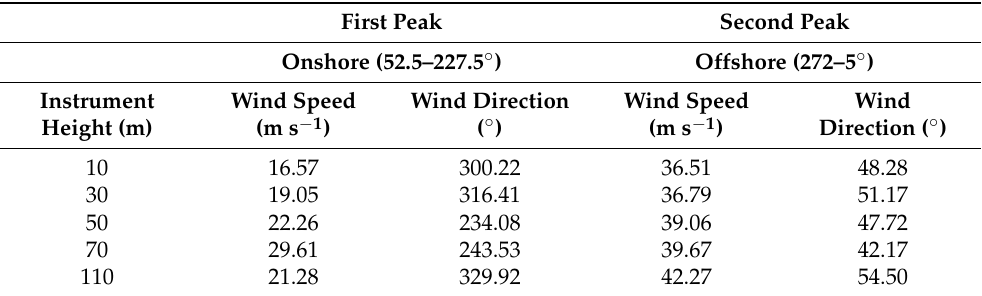
Figure 7. Temporal changes in the 10-min averaged wind speed ( u n ) and wind direction (WD) obtained from the sonic anemometers on the five heights [( a ) 110 m, ( b ) 70 m, ( c ) 50 m, ( d ) 30 m, and ( e ) 10 m of the two towers during Typhoon Maria (2018). Section A is the time period before typhoon landfall on 11 July and Section B is the time period after typhoon landfall. Table 1. Maximum 10-min mean wind speed and directions during Typhoon Maria in 2018.